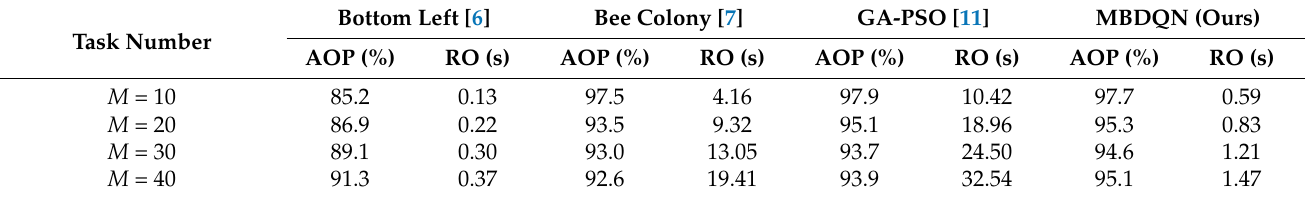
Table 5. Comparisons of the proposed MBQDN with existing methods [6,7,11] on the zero-waste